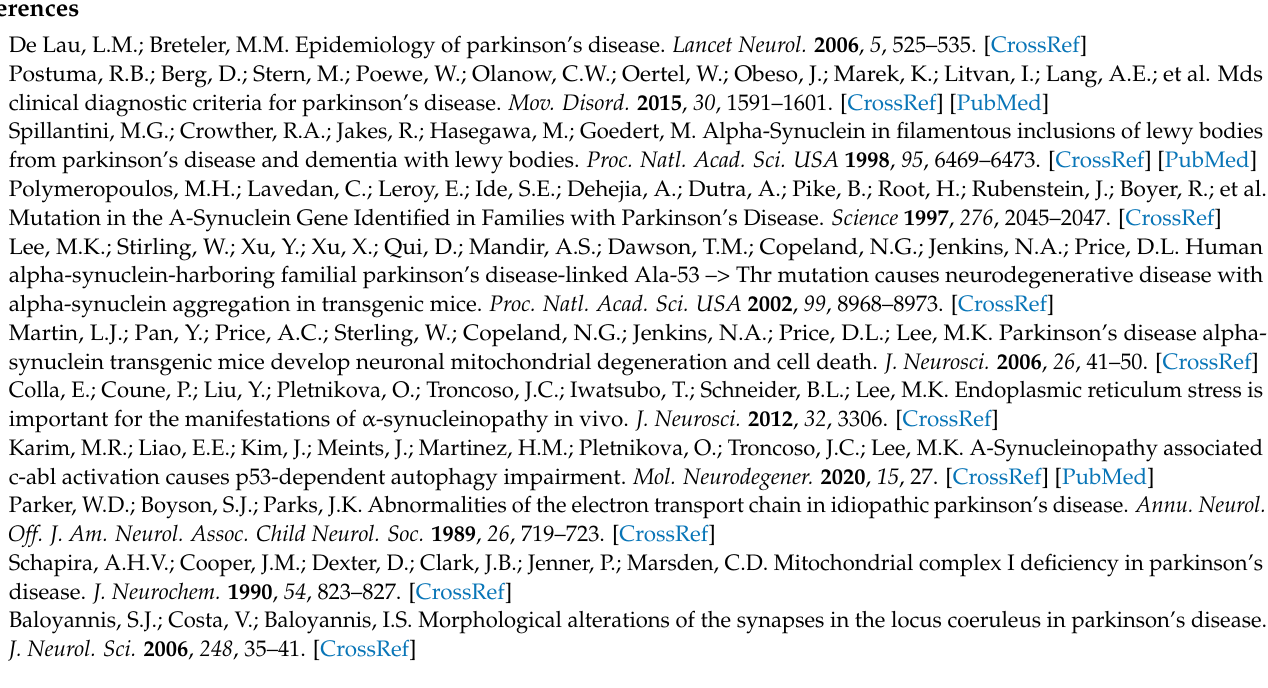
Figure S3: Western blot of TgA53T G2-3 total cortical lysate and N2A total cell lysate for p(Ser637)Drp1; Figure S4: Widespread transgene expression with abundant pSyn aggregation in the pons and the cortex; Figure S5: Confocal imaging of pSyn and mitochondria (TOM20) in control and TgA53T G2-3 mice and quantification of mitochondrial morphometrics; Figure S6: 2D Analysis of mitochondria in TgA53T G2-3 Pons from maximum intensity z-level projections of confocal images; Figure S7: Confocal imaging of hSyn immunoreactivity in 3 months old tgA53T G2-3 mice and age-matched controls (Uncropped Gels/Western